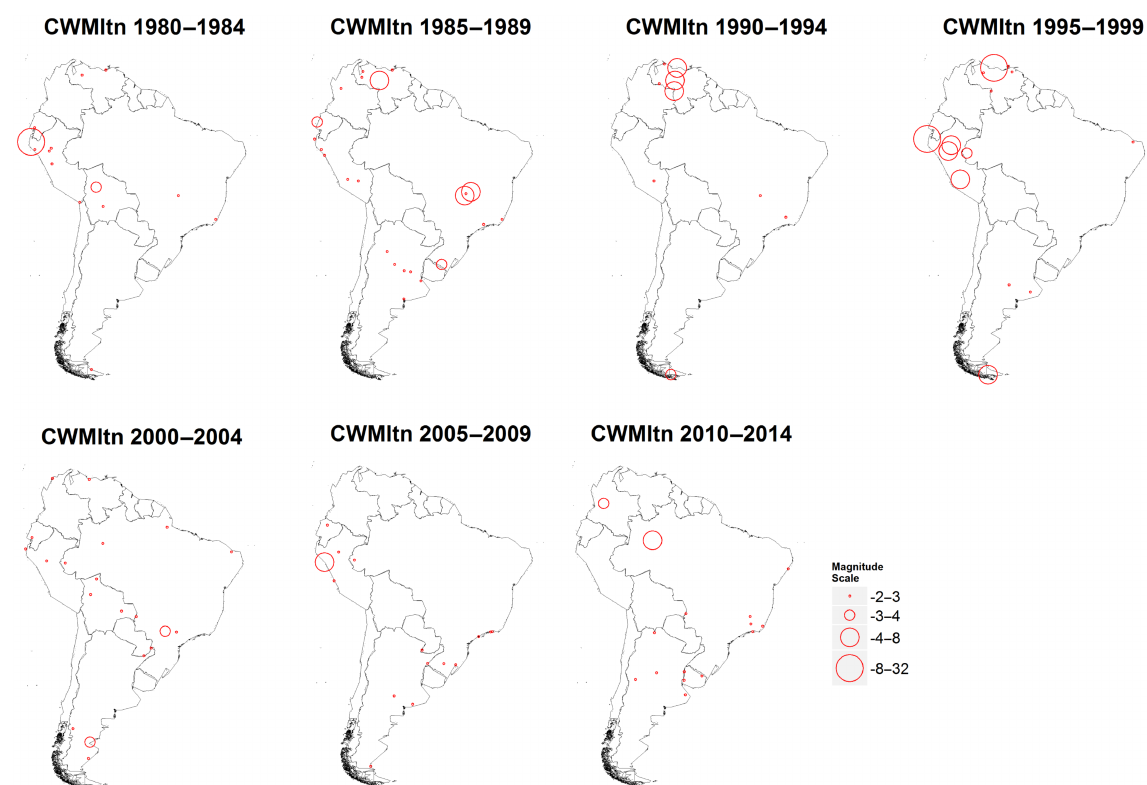
Figure 5. Cold Wave Magnitude Index of minimum temperature (CWMI tn ) for 5-year periods from 1980 to 2014. The magnitude scale follows the classification of cold waves provided in Table